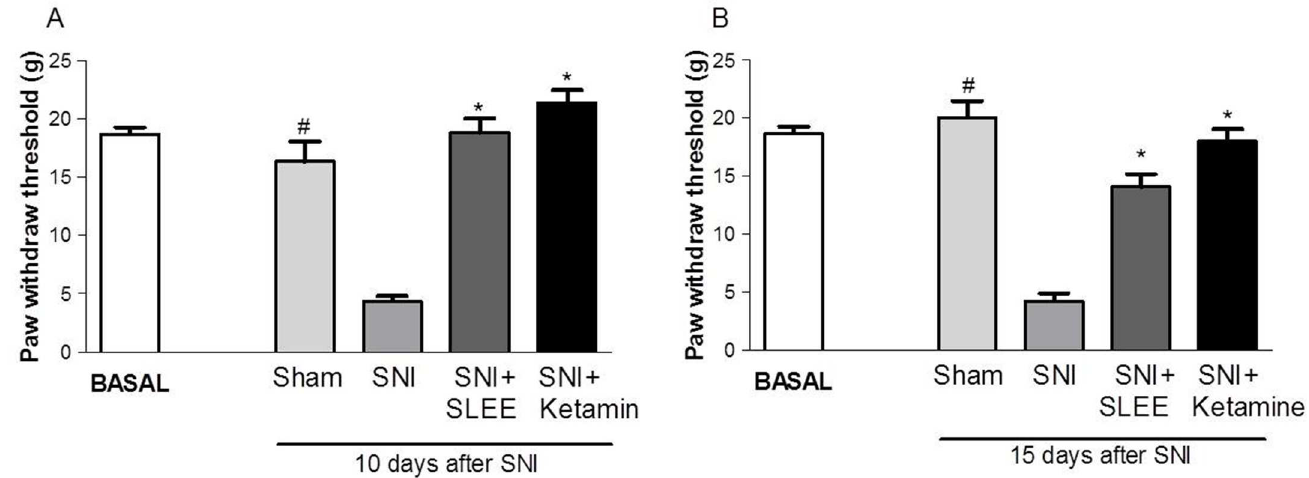
Fig 1. Effect of oral administration of SLEE on SNI-induced increasesin mechanical sensitivity (paw withdraw threshold) in rats. A and B show the values 10 and 15 days after SNI, respectively.The bars represent the basal value (before surgery) and post-surgery Sham, SNI, SNI+SLEE (100 mg/kg, p.o.) SNI + ketamine(10 mg/kg, i.p.). Animalswere treated once a day for 15 days after the SNI and sham procedures.Bars express the mean ± SEM(n = 8) comparing the SNI vs. treated and sham groups. * P < 0.001or # P < 0.001.